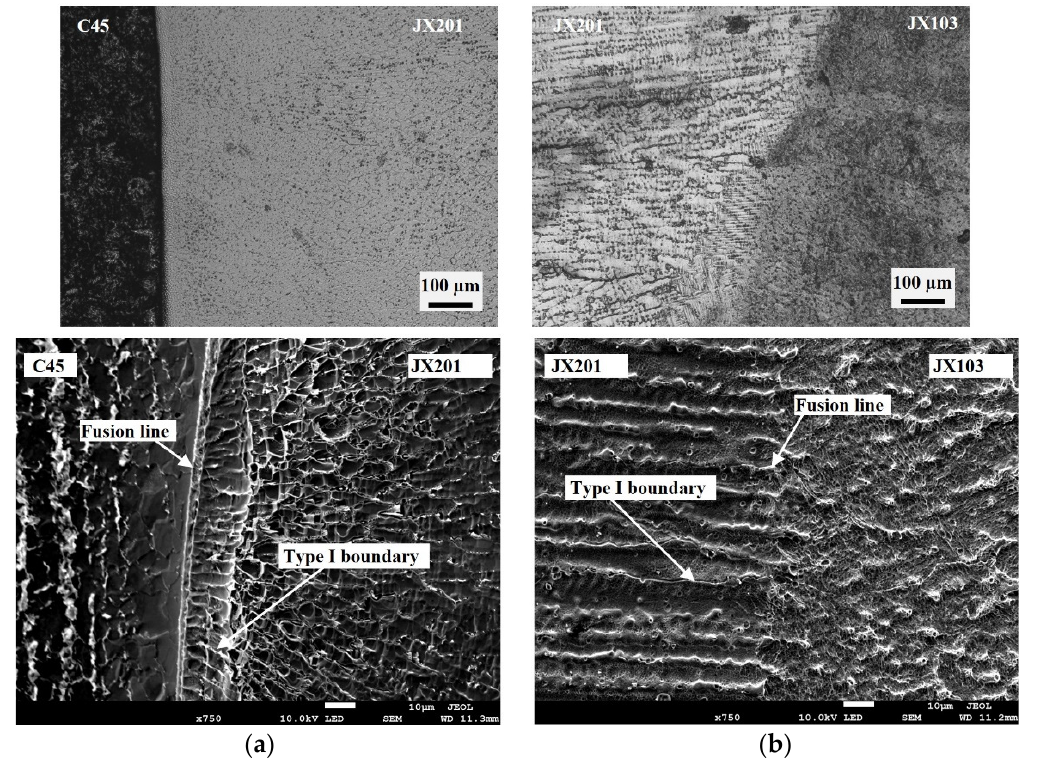
Figure 7. Microstructures of the two fusion boundaries: ( a ) Fusion boundary of JX201 and C45; ( b ) Fusion boundary of JX103 and JX201.